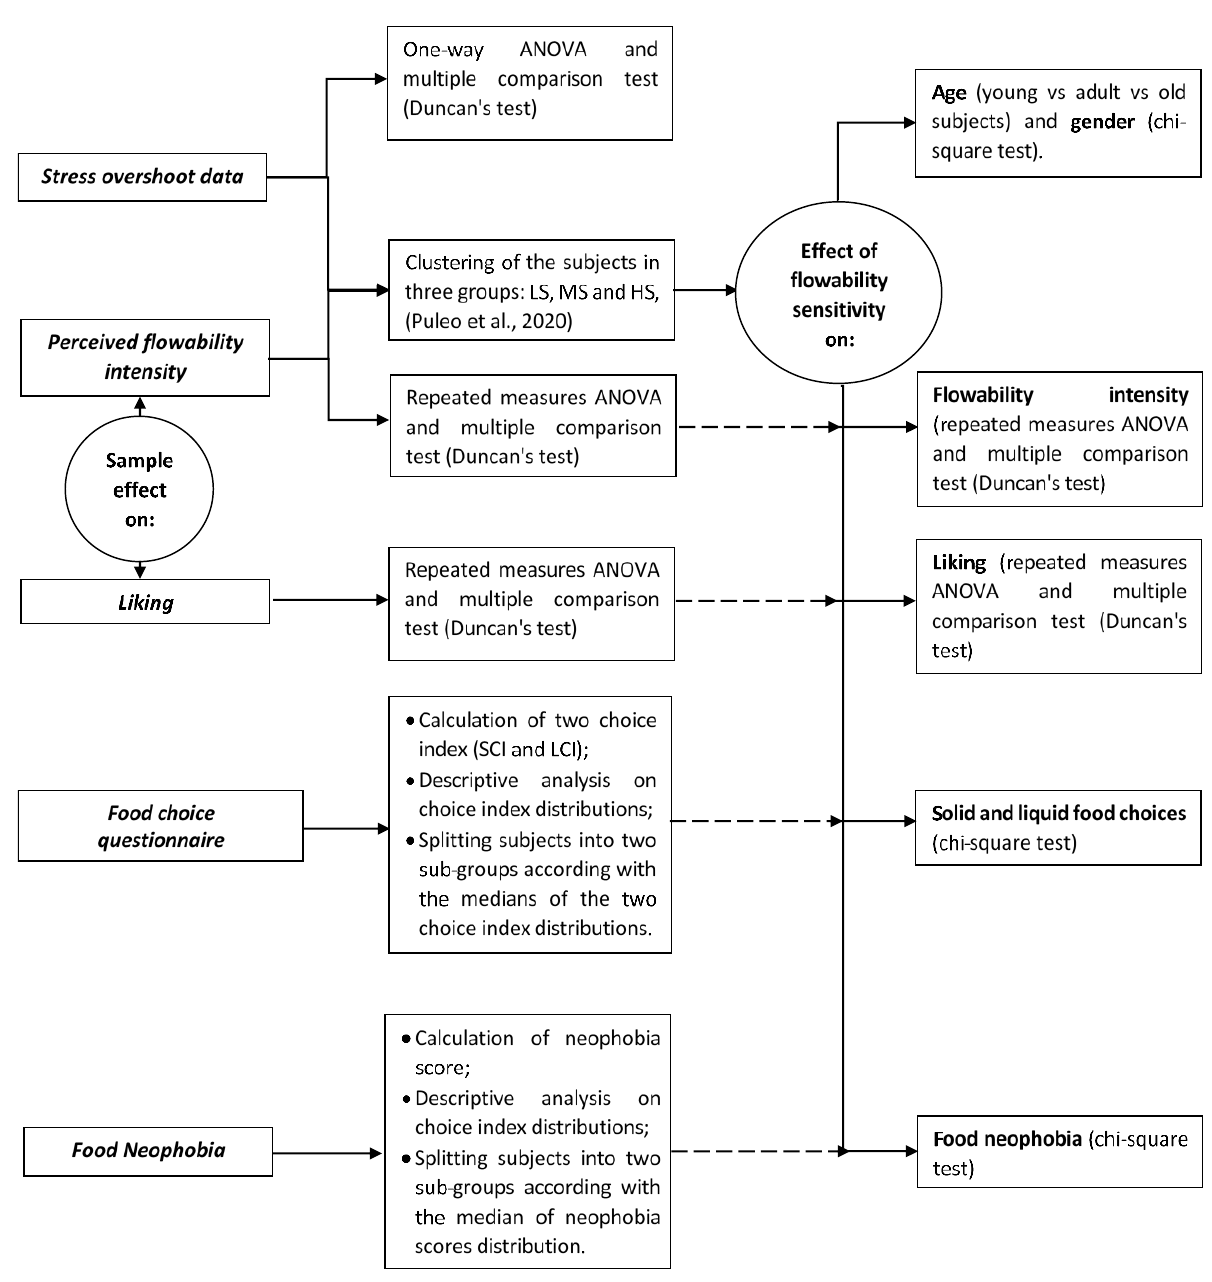
Figure 1. Flowchart of the data analysis.